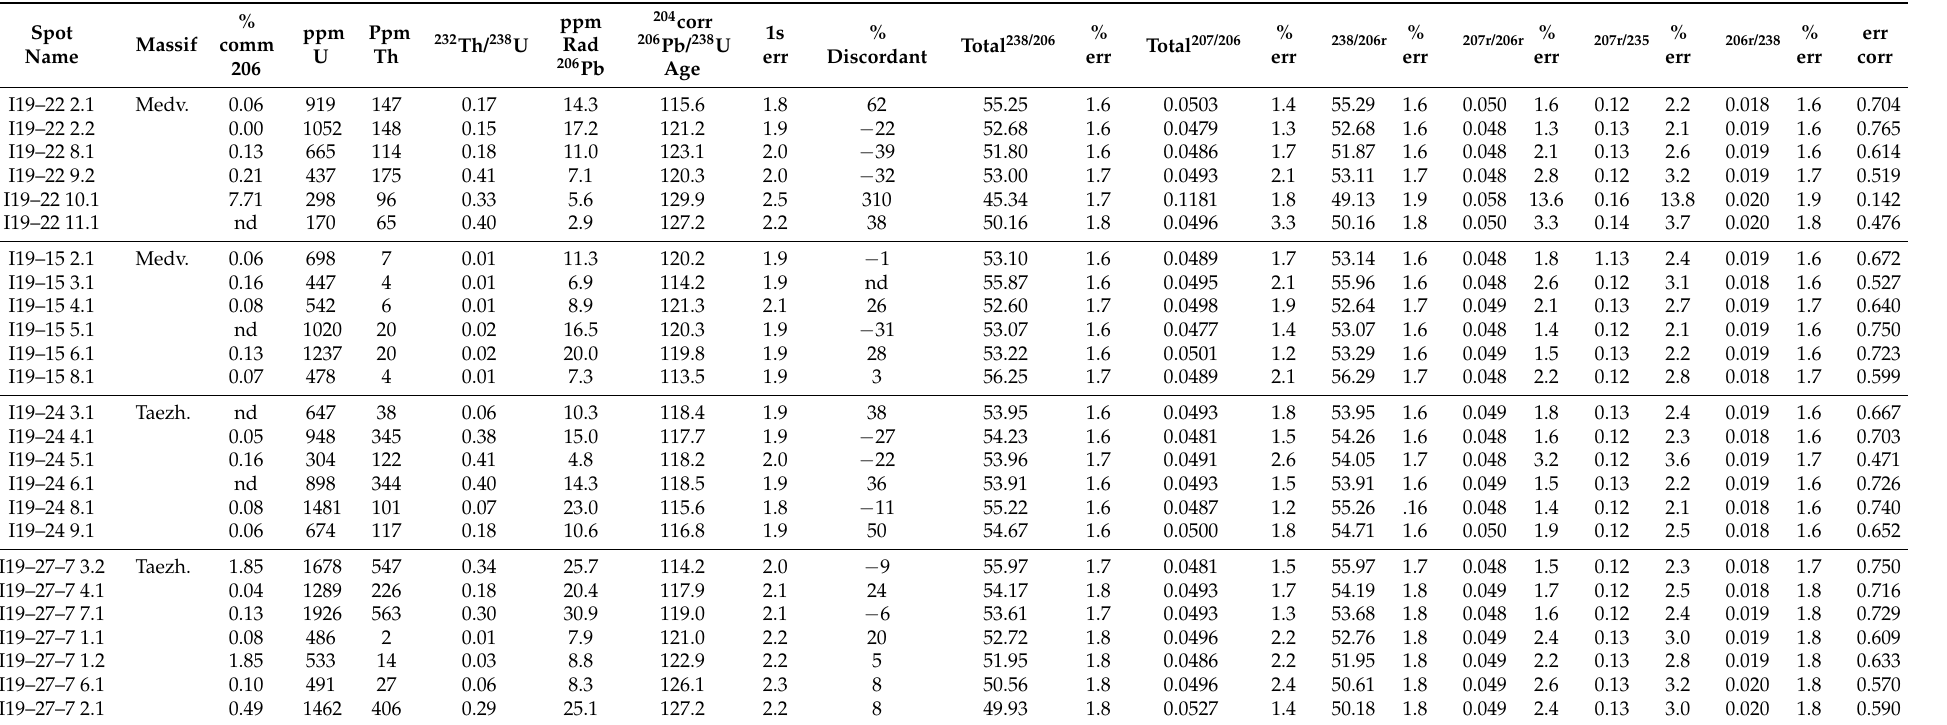
Table A4. Results of the U-Th-Pb isotopic studies of zircons (SIMS SHRIMP-II) from the igneous rocks of Medvedev and Taezhniy massifs (nd—not